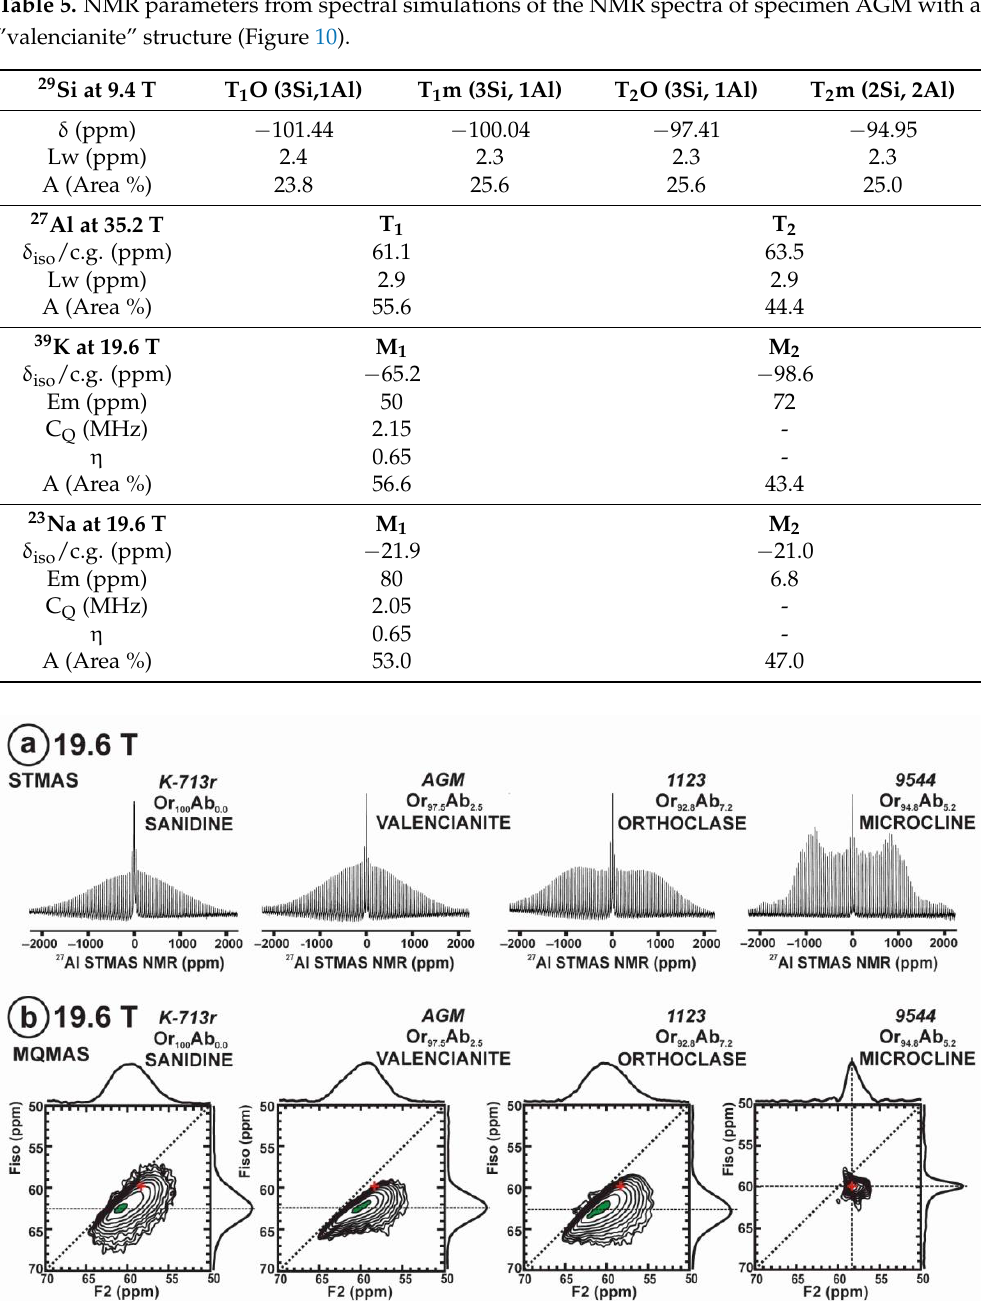
Figure 11. The 27 Al STMAS NMR ( a ) and 27 Al MQMAS NMR ( b ) at 19.6 T of sanidine in specimen K-713r Or 100 Ab 0.0 , “valencianite” in specimen AGM Or 97.5 Ab 2.5 , orthoclase in specimen 1123 Or 92.8 Ab 7.2 , and (low) microcline in specimen 9544 Or 94.8 Ab 5.2 . In the MQMAS, the MAS spectra are on top as a projection the F2 axis, and the one-dimension spectra are at the right side as a projection on the Fiso isotropic dimension, where the second-order quadrupolar broadening effects are considerably attenuated. The red cross is the position of the site for Al atoms in T 1 O (4Si,0Al) in the fully ordered microcline from NMR or the “X - ray low microcline” variant by RSTs. Table 5. NMR parameters from spectral simulations of the NMR spectra of specimen AGM with a ”valencianite” structure (Figure 10).